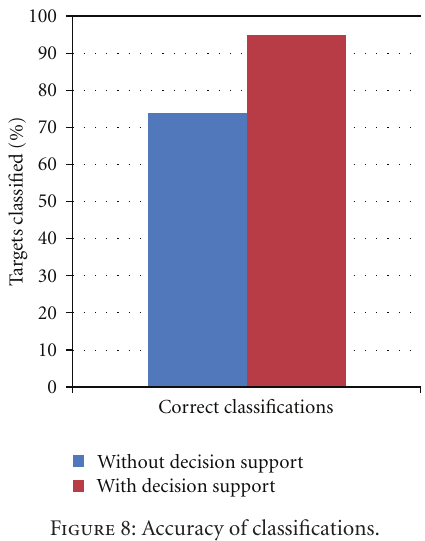
Figure 6: Time for identifications.